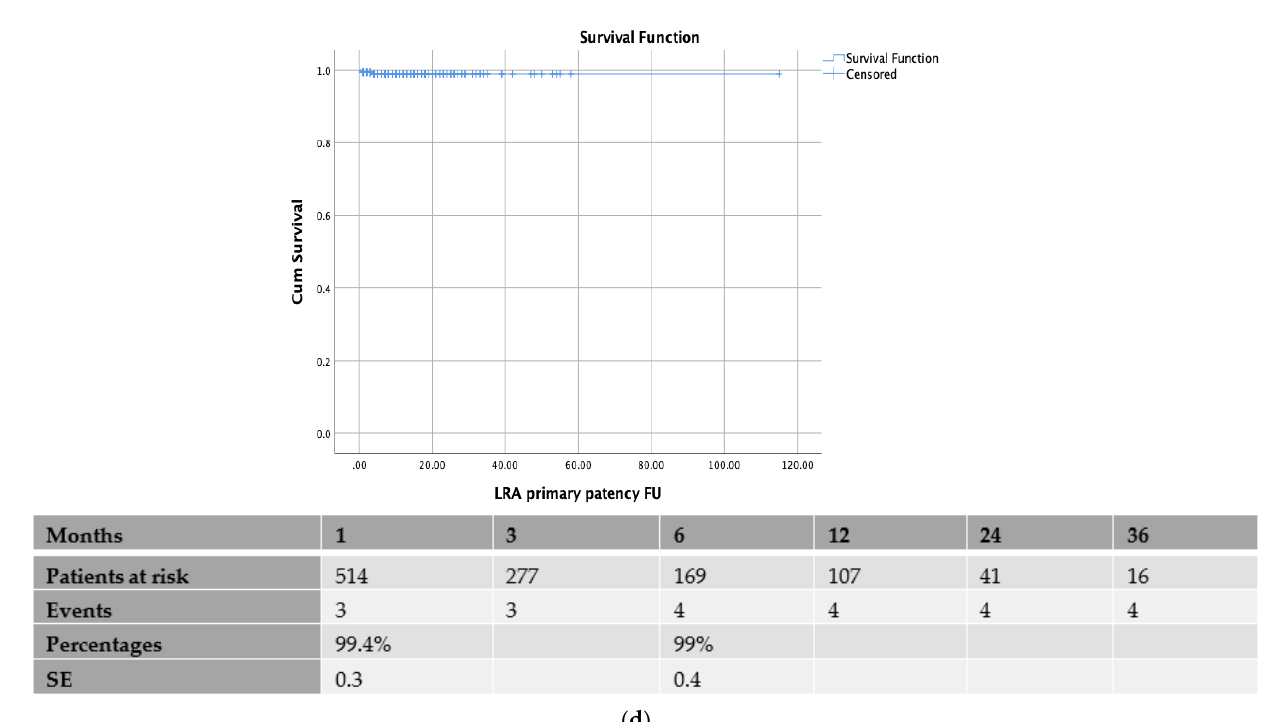
Figure 1. ( a ) Patency of coeliac trunk (CT) bridging covered stent. SE: standard error; ( b ) Patency of superior mesenteric artery (SMA) bridging covered stent. SE: standard error; ( c ) Patency of right renal artery (RRA) bridging covered stent. SE: standard error; ( d ) Patency of left renal artery (LRA) bridging covered stent. SE: standard error.